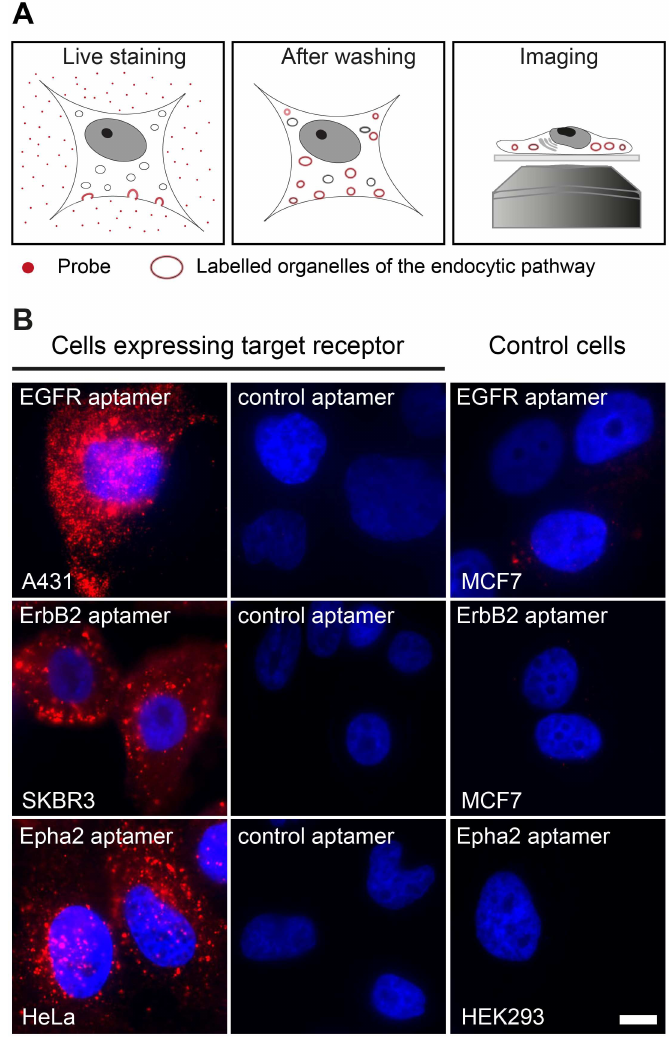
Fig 1. Live staining and aptamerspecificity. ( A ) Simple scheme describing the procedure to stain living cells using aptamers or antibodies(probes). Cells are incubatedwith aptamer or antibodies allowingthe internalization of the probes by the endocytosisof the receptor. ( B ) Aptamers againstEGFR, ErbB2 and Epha2 were used to live-stainhumancell lines expressingthese receptors (A431, SKB3 and HeLa cells respectively). A control aptamer with randomized sequenceof equivalent length and coupledto the same fluorophore was used to stain these cell lines. Additionally,cell lines that do not express such receptors were used as negativecontrol cells (MCF7 cells are negativefor EGFR and ErbB2; HEK293cells are negativefor Epha2). Both controls, the cell lines not expressingthe receptorand the randomized aptamer show virtually no aptamer signal (nuclei were DAPI stained, displayedin blue). All images were acquiredusing an epifluorescence microscope with the same settings and they are equallyscaled to allow a direct comparison. Scale bar represents 5 μ